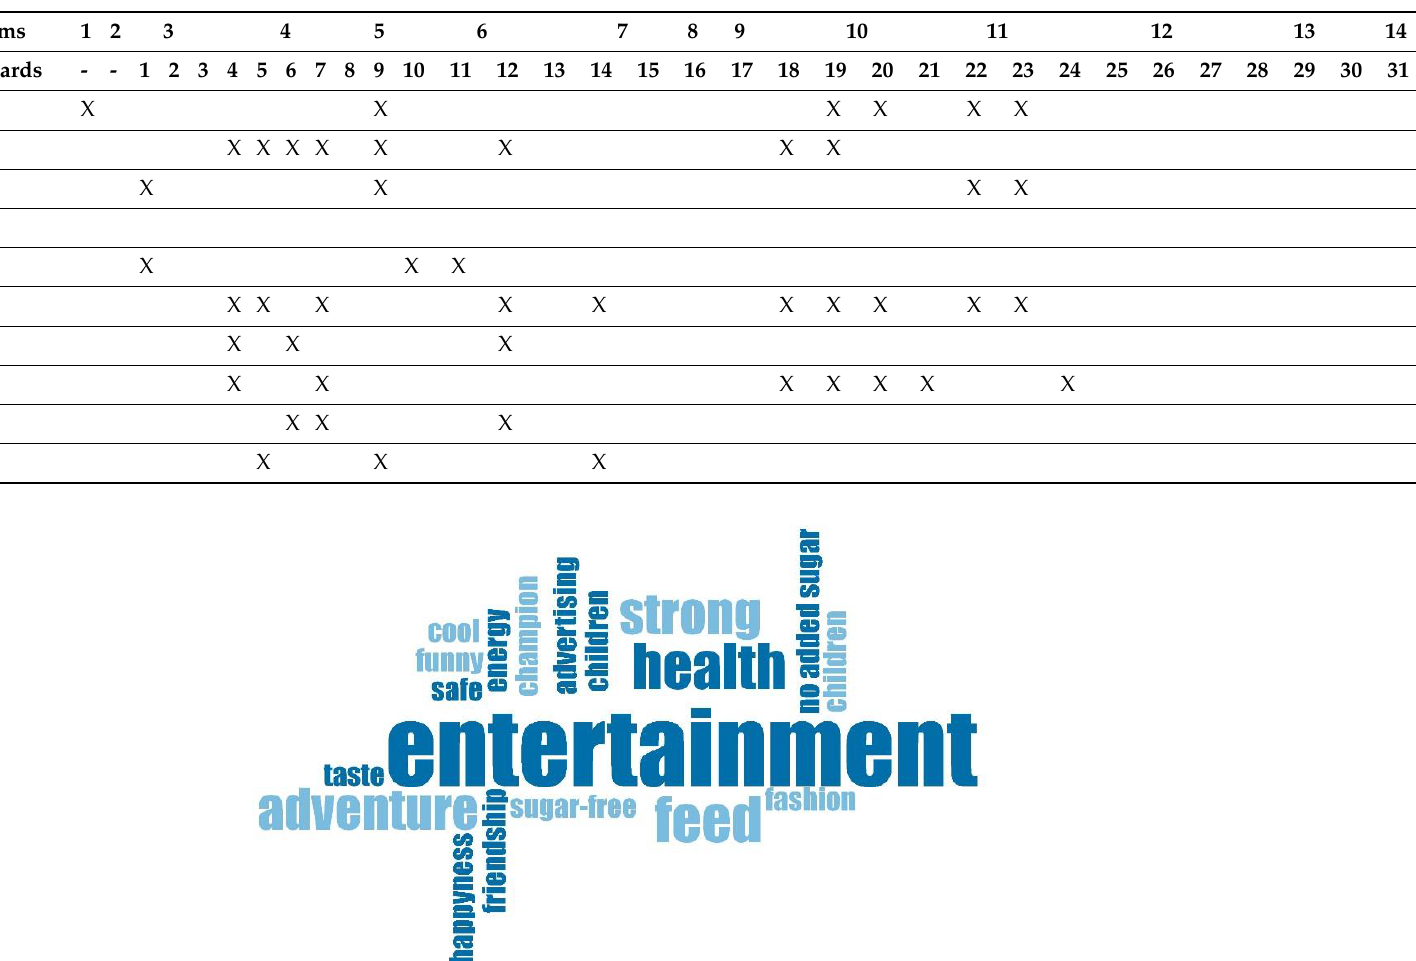
Table 2. Frequency of non-compliance with PAOS Code norms and ethical standards by food and beverage ads (F&B) aimed at children through mobile devices in Spain in 2019.